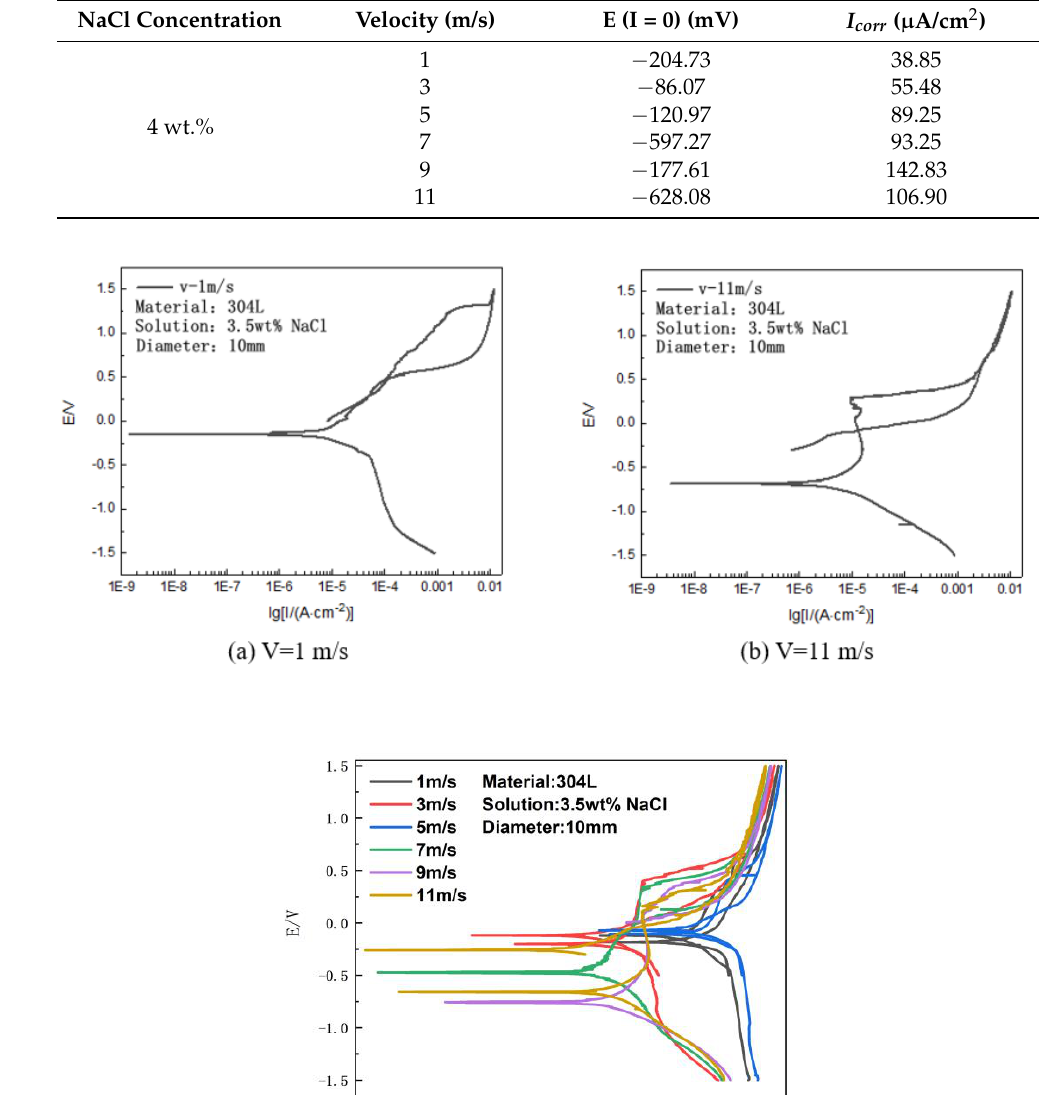
Table 2. Fitting values of polarization curves of 304L stainless steel at different flow velocities.